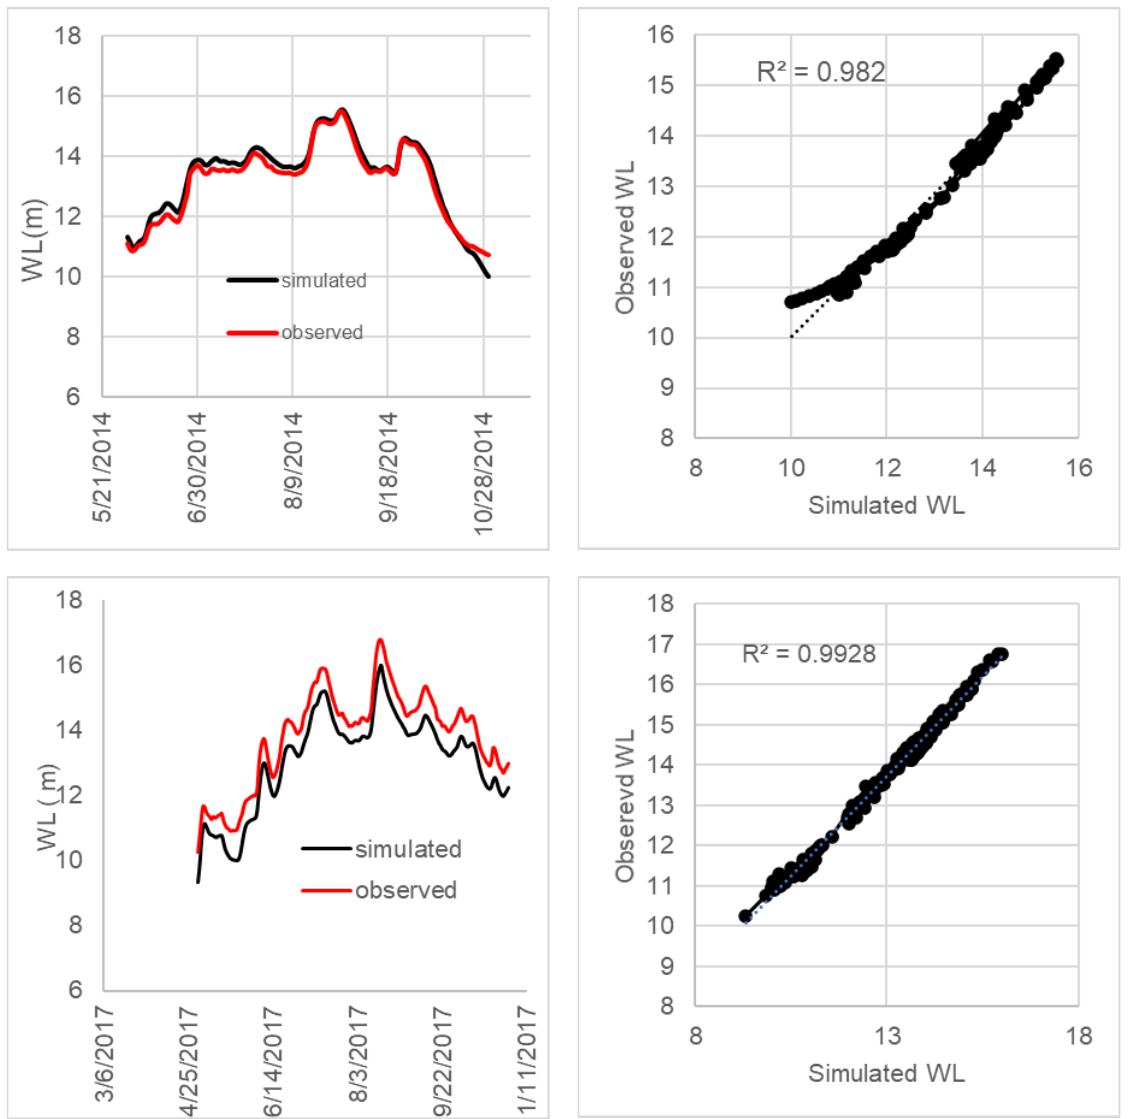
Fig. 3. Calibration and validation